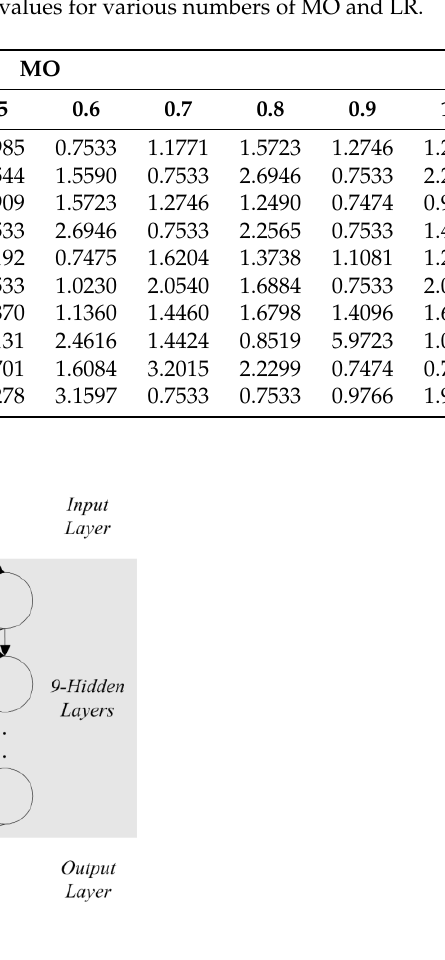
Figure 10. Comparison of the simulated and predicted times.